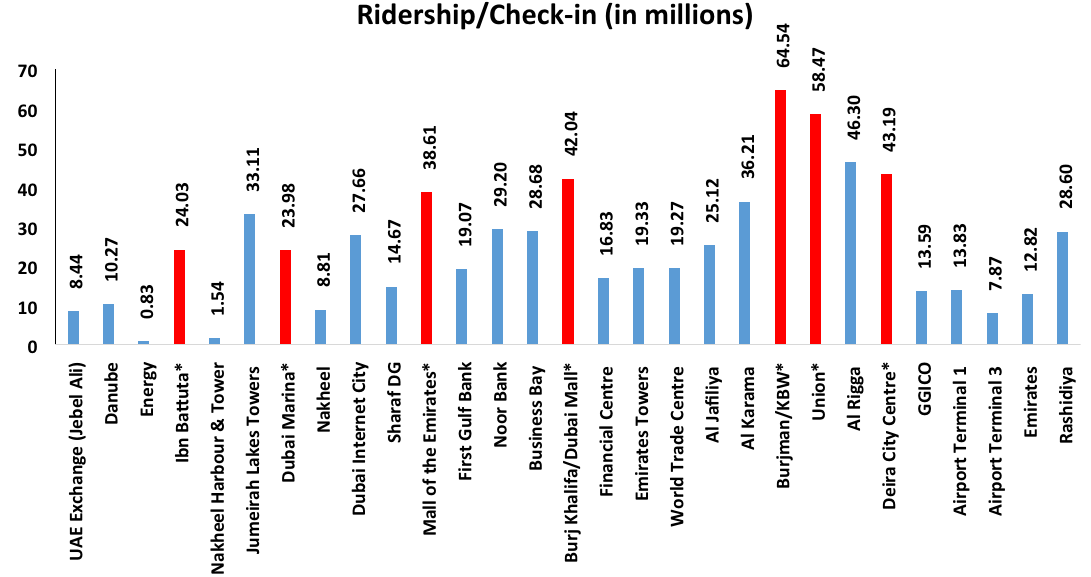
Fig. 4 Number of passengers checking in at stations of the Dubai Metro Redline during the period from 2013 to 2018 Source : Rail Operations Department (RTA) Database for Dubai Metro operations from 2013 to